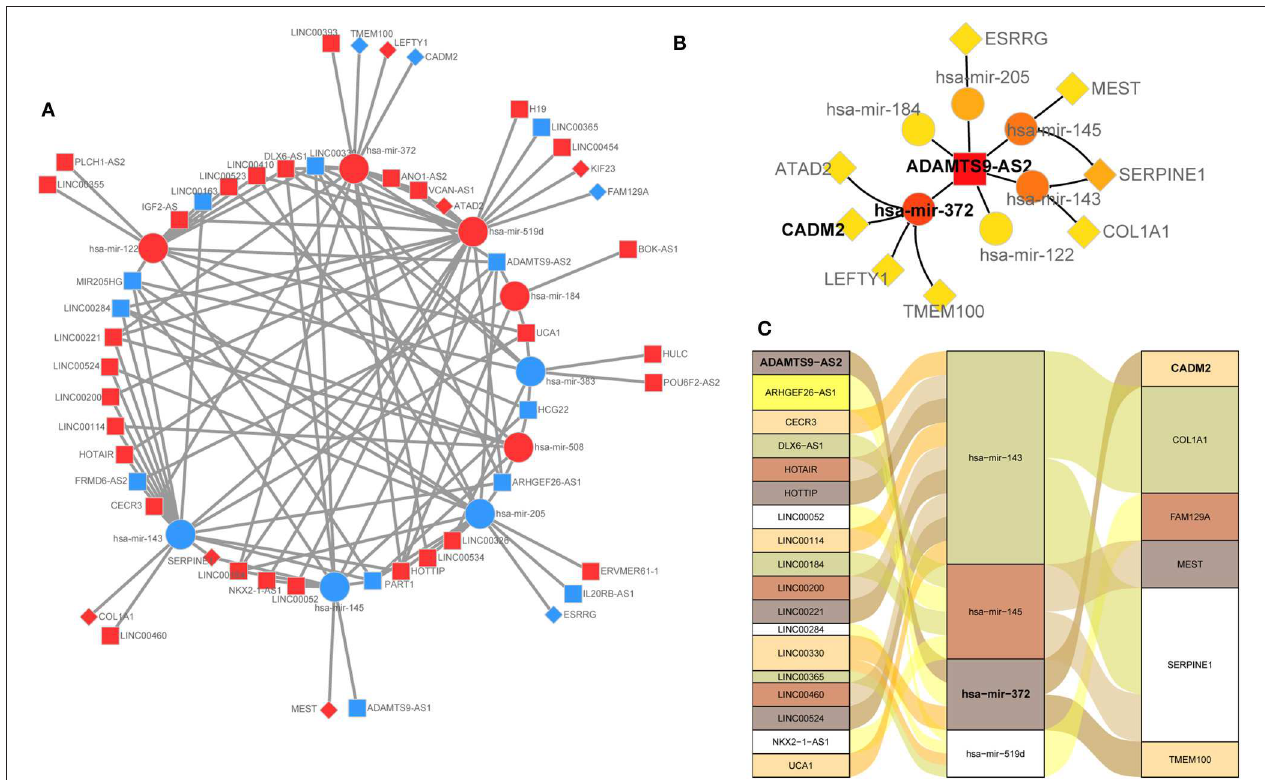
FIGURE 3 | (A) Overview of the ceRNA network in gastric cancer. Up-regulation was represented by ed nodes, while down-regulation was represented by the blue nodes. round rectangle, ellipse, and diamonds represent lncRNAs, miRNAs, and mRNA, respectively. (B) lncRNA ADAMTS9-AS2 is a hub gene that directly interacted with 6 miRNAs, and indirectly interacted with 8 mRNAs. (C) lncRNA-miRNA-mRNA regulatory axes extracted from the ceRNA